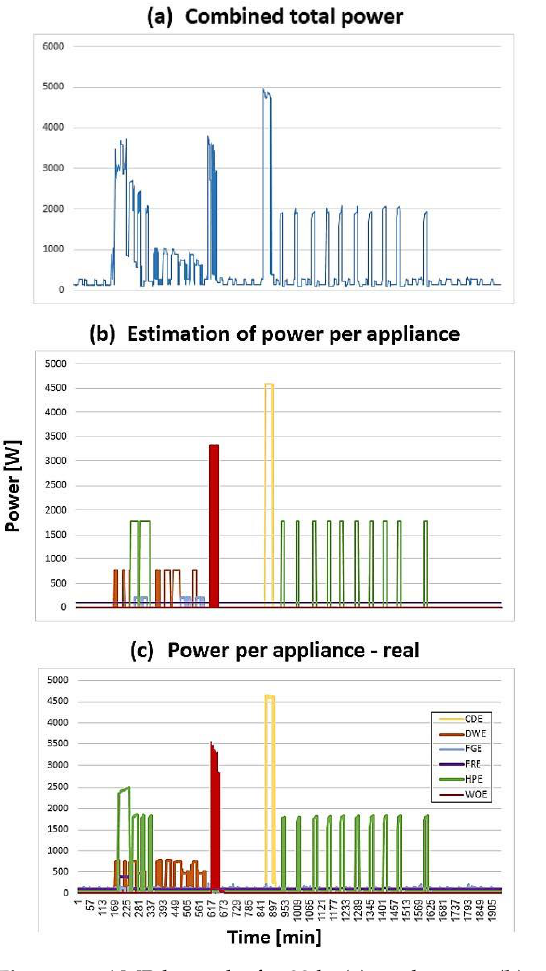
Figure 11. AMPds results for 32 h: ( a ) total power, ( b ) estimated disaggregated power consumption, and ( c ) true disaggregated power.